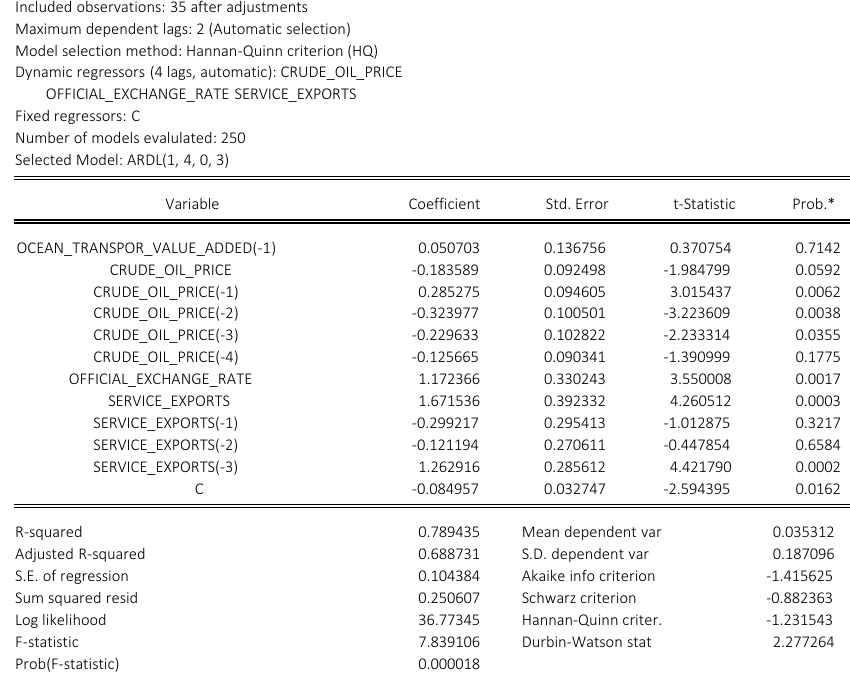
Figure 8. Development in crude oil prices and ocean transport value added during the period 1979–2018